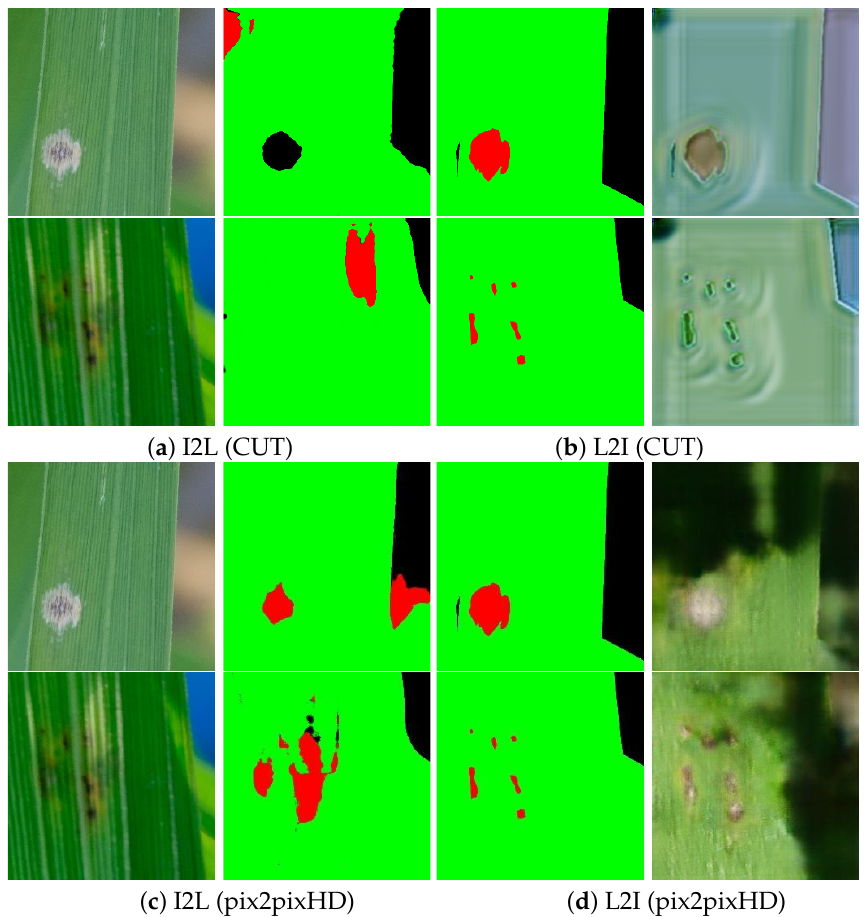
Figure 11. I2L and L2I style transfer results for the respective GANs in Rice